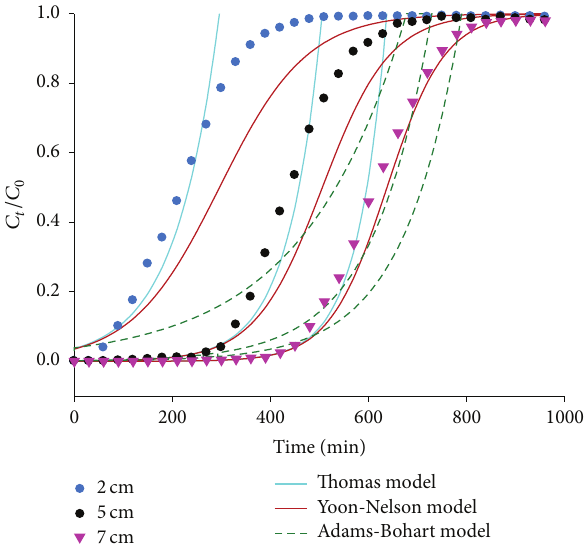
Figure 8: Effect of bed depth on breakthrough curve (flow rates 15mL/min; concentration 20mg/L; pH 5.2).